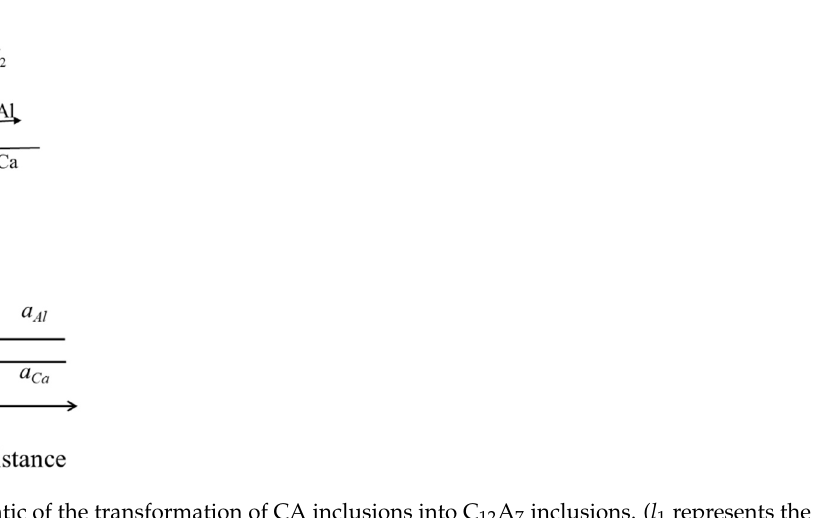
Figure 7. Schematic of the transformation of CA inclusions into C 12 A 7 inclusions. ( l 1 represents the interface layer between CA and C 12 A 7 inclusions, l 2 represent that surface layer between the C 12 A 7 inclusion and the molten steel boundary, a CA indicates the activity of CA inclusions, a Al indicates the activity of Al, a Ca indicates the activity of Ca. ）